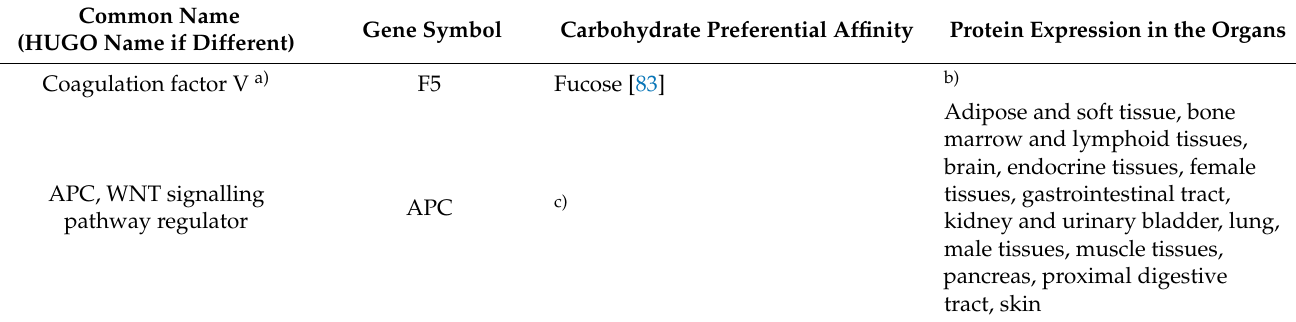
Table 3. Human f-type lectins, their carbohydrate ligands and protein expression in the organs.